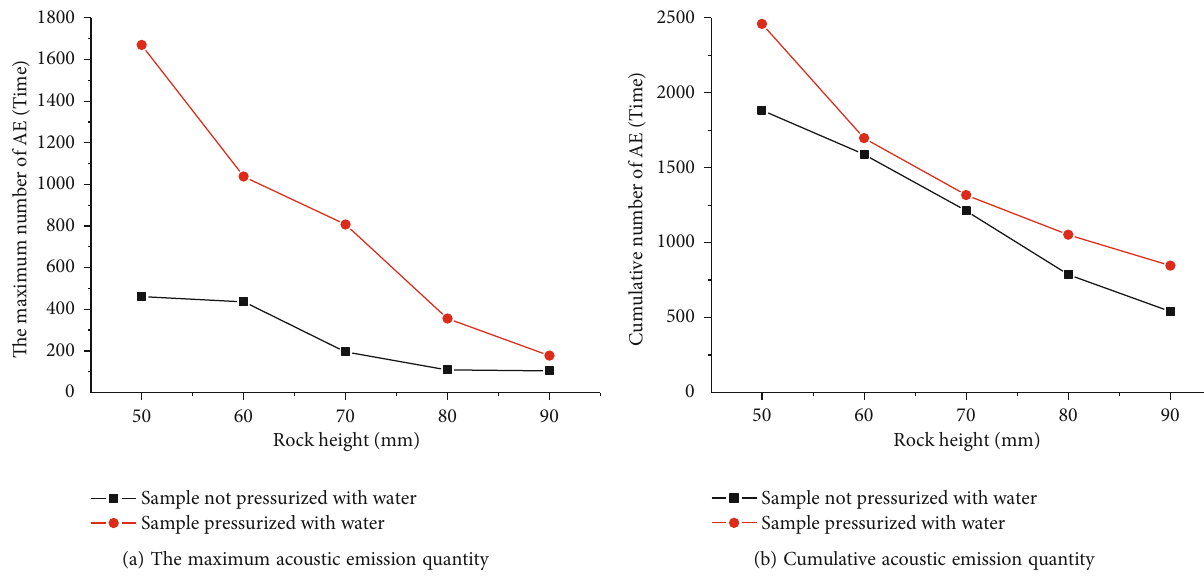
Figure 9: Acoustic emission